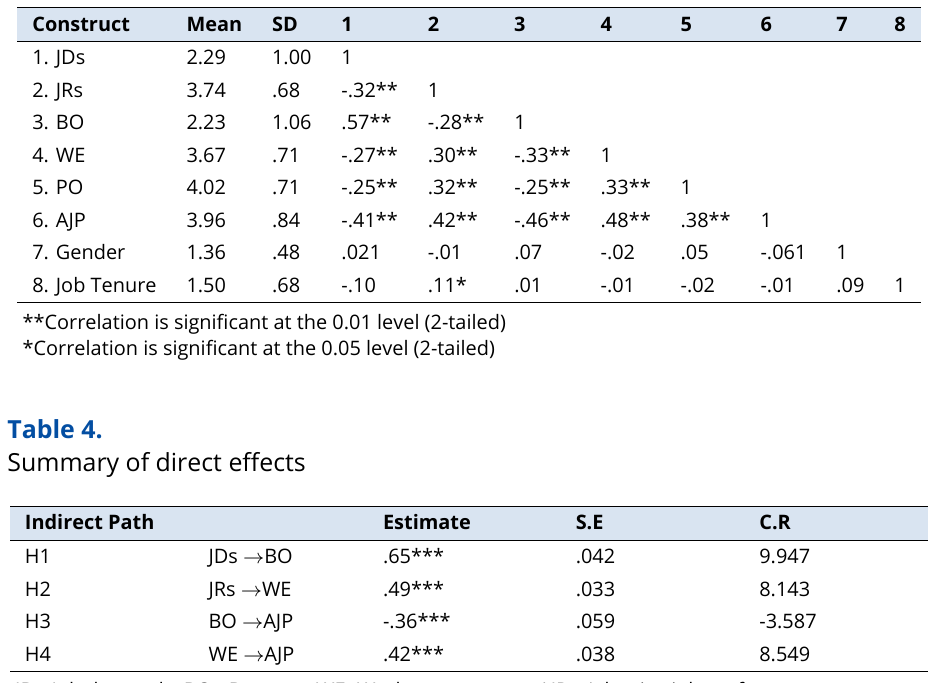
Descriptive and Correlations Results